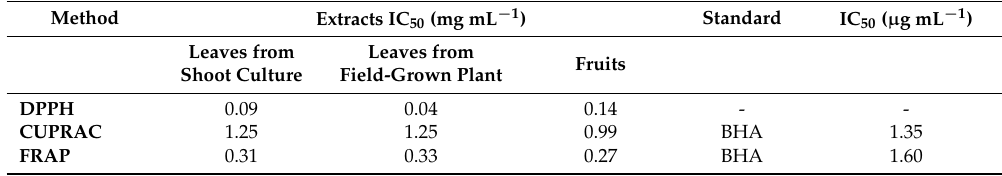
Table 5. Antioxidant effect of ethanolic extracts from leaves of in vitro-propagated plantlets, field-grown plant, and fruits of Chaenomeles japonica